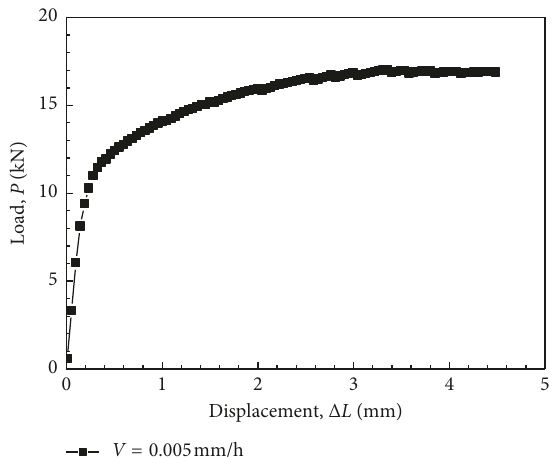
Figure 4: The relationship between tensile load and load line displacement.